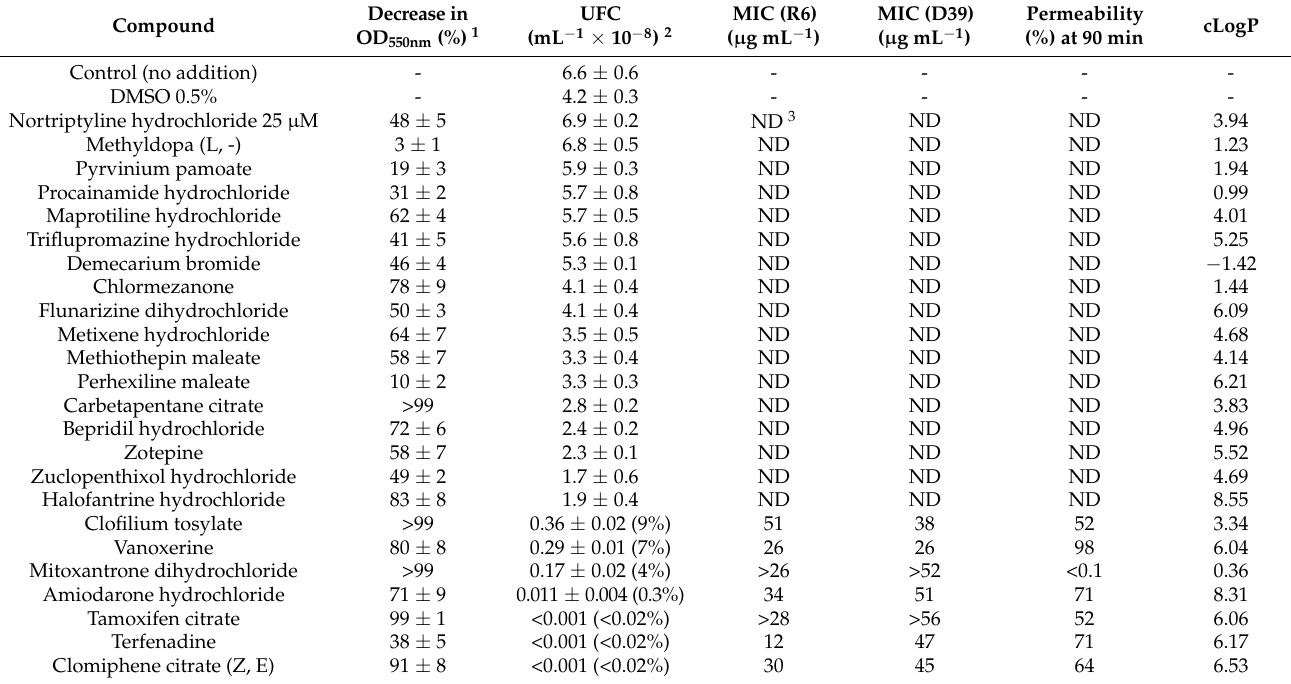
Table 1. Antibacterial effects of selected drugs at 25 µ M